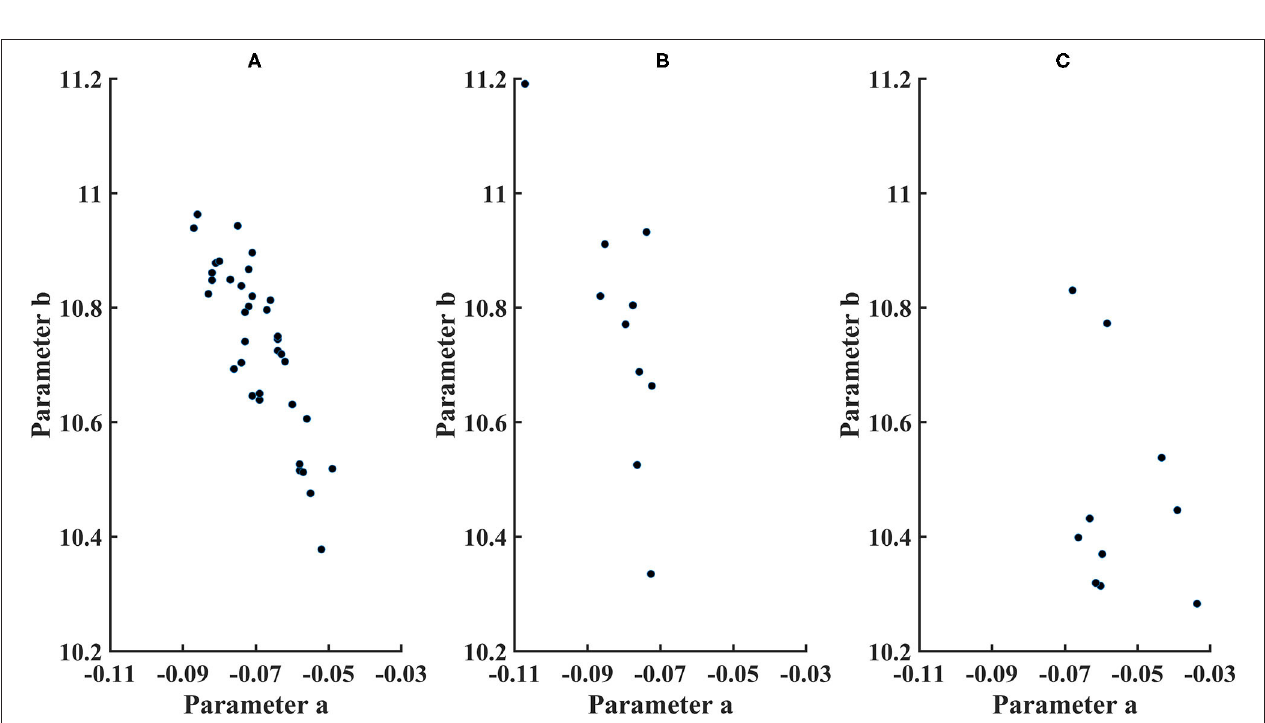
FIGURE 5 | Parameters for cone distribution from the exponential model ln ( cone density ) = a * microns eccentricity + b , with a plotted as a *100. (A) younger control subjects, (B) older control subjects, and (C) diabetic subjects.